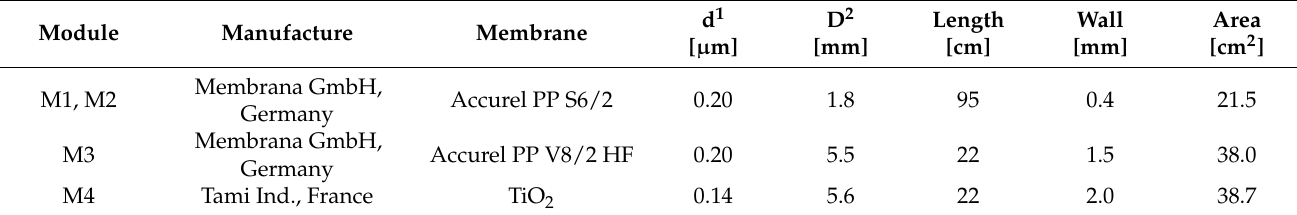
Table 2. Characteristics of the MF membranes used in the experiments—manufacturers data.